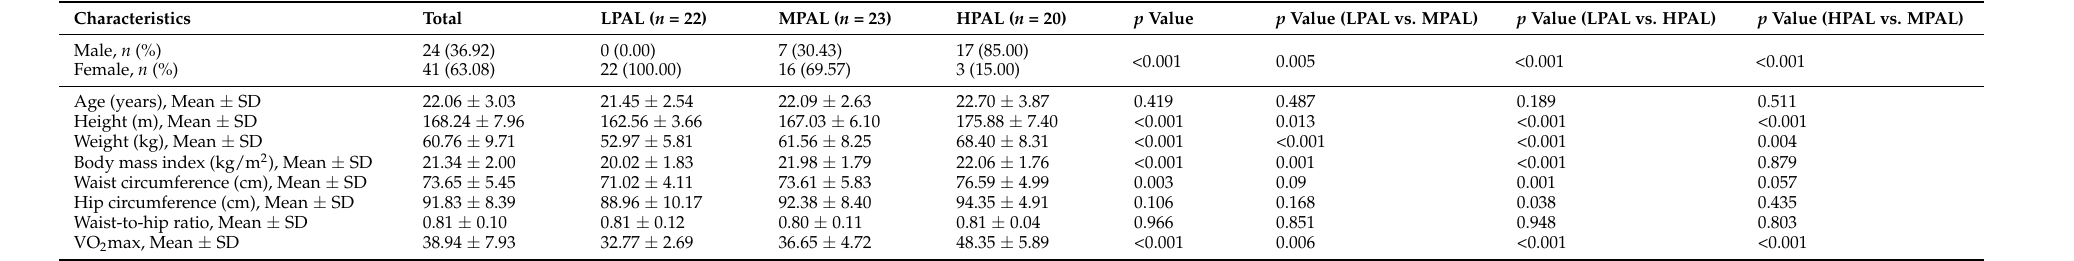
Table 1. Physical characteristics of the participants.